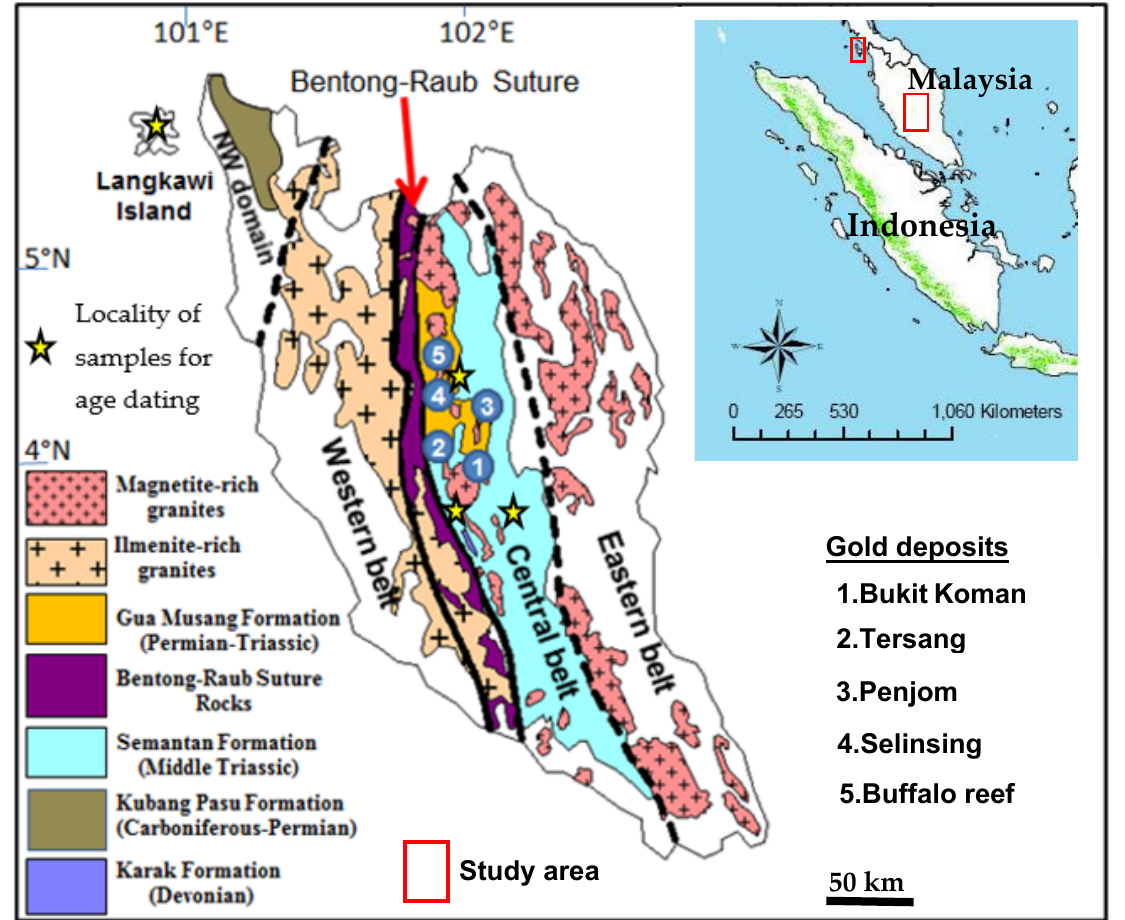
Figure 1. Geological map of the Malaysian Peninsular showing the NW domain, the Western belt, the Central belt, and the Eastern Belt (modified from [7]). Note the locations of Tersang (2) and Selinsing (4) gold deposits for this research work. The two blue boxes in the index map indicate that both the Central belt and Langkawi Islands are study areas. Samples were collected from both areas. The star on the Langkawi Islands represents the sample locality for GRL ‐ 0313. The star next to the Selinsing gold deposit is where samples GM ‐ 0113 and GM ‐ 0213 were collected. Southwest of Bukit Koman is where BE ‐ 11513 was collected. Southeast of Bukit Koman in the Semantan Formation is where samples ME ‐ 6512 and ME ‐ 11813 were taken from. Gold mining is particularly concentrated in the Permo ‐ Triassic Gua Musang Formation as this formation contains sulphide mineralization. Common sulphide minerals found in the Gua Musang rocks are pyrite, galena, sphalerite and chalcopyrite. Pyritic mineralization is also found in the Semantan Formation and granitoid